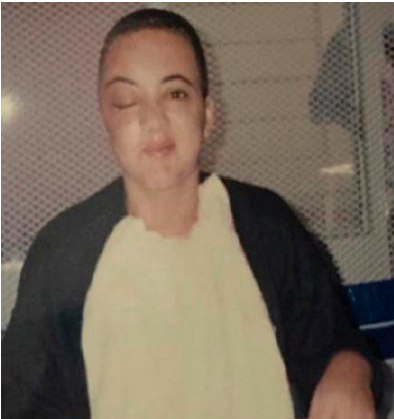
Figure 2. Patient after procedures showing facial hemiplegia on the right side.